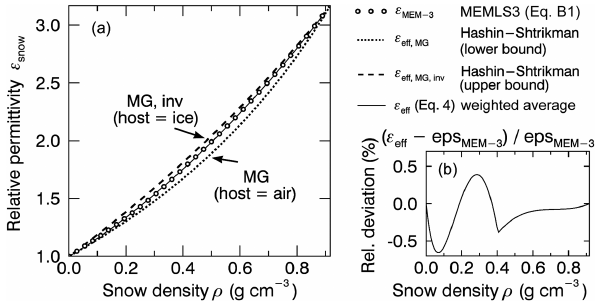
Figure B1. (a) Relative permittivity of dry snow ε MEM-3 (open cir- cles) according to Eq. (B1) in comparison to the upper and lower Hashin–Shtrikman bound. The solid lines shows the weighted aver- age of the MG formulas, ε eff , Eq. (4). (b) The relative deviation of ε eff with respect to ε MEM-3 is below 0.7% for all snow